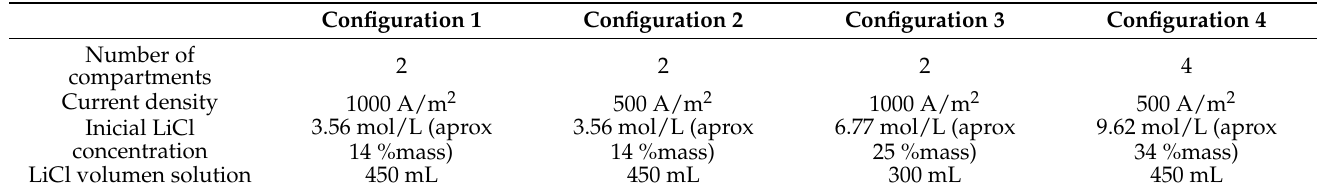
Table 2. Experimental test setup for validation.